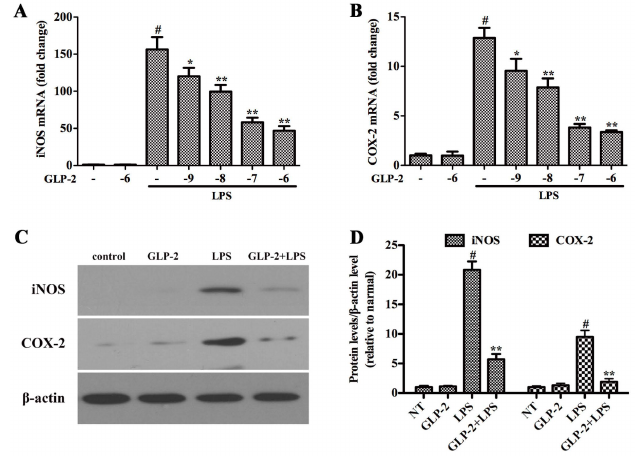
Figure 1. Glucagon-like peptide-2 (GLP-2) attenuates lipopolysaccharide (LPS)-induced iNOS and COX-2 in BV-2 cells. ( A , B ) The mRNA expression of iNOS and COX-2. BV-2 cells were pretreated with GLP-2 (10 ´ 9 , 10 ´ 8 , 10 ´ 7 , and 10 ´ 6 M) 1 h prior to incubation of LPS (1 µ g/mL) for 4 h; ( C , D ) Western blotting analysis of iNOS and COX-2. BV-2 cells were pretreated with 10 ´ 6 M GLP-2 for 1 h followed by LPS treatment at 1 µ g/mL for 4 h. The mRNA and protein levels of iNOS and COX-2 normalized to β -actin. Each value was then expressed to non-treated (NT) control group, which was set as 1.00. Results are expressed as mean ˘ SD for each group from three independent experiments. # Significant compared with NT, p < 0.05; * p < 0.05 and ** p < 0.01 versus the GLP-2-untreated LPS-stimulated group.